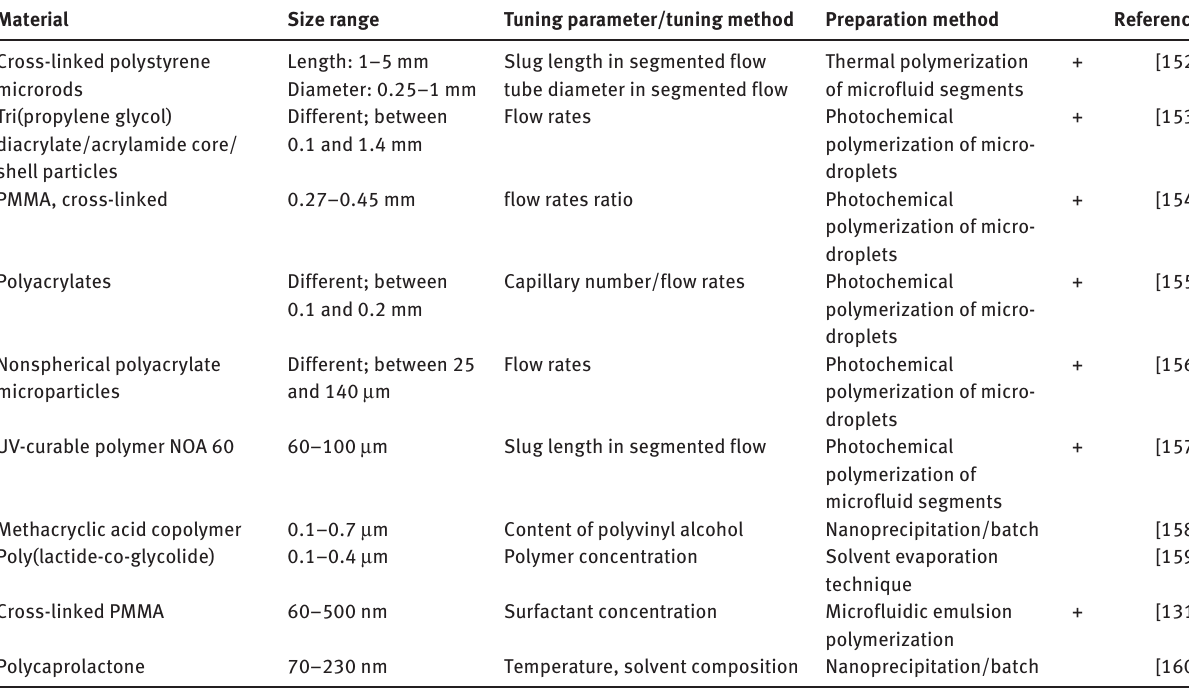
Table 5 Tuning of the size of polymer microparticles and nanoparticles